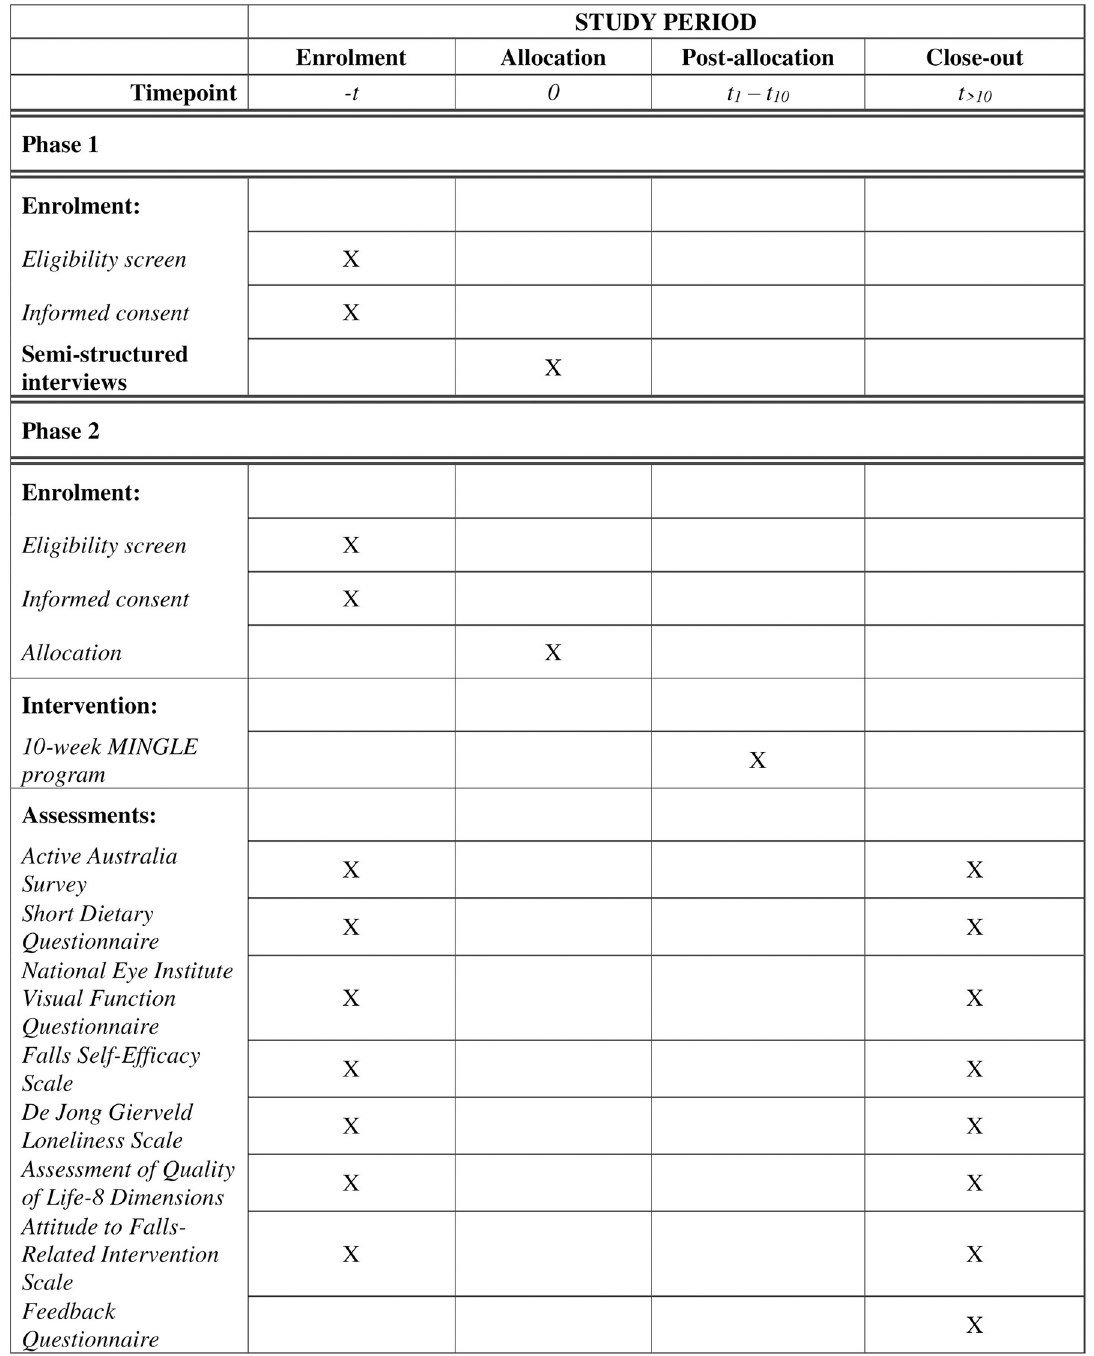
Fig 1. MINGLE pilot trial schedule of enrolment, interventions, and assessments.